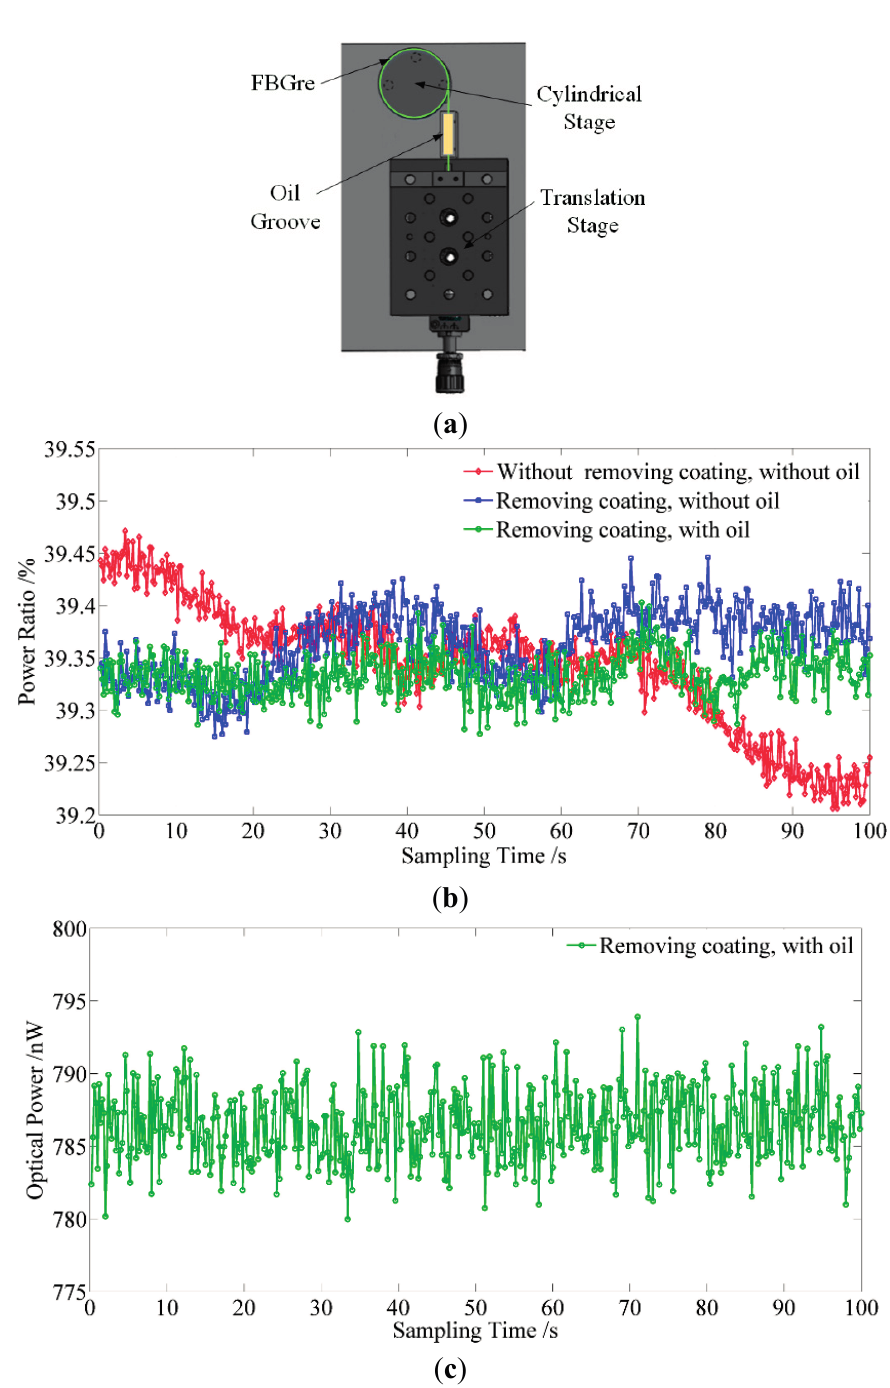
Figure 9. Experiment setup and result of the mechanical adjustment: ( a ) schematic diagram of the mechanical adjustment; ( b ) experimental results of the stability of the power ratio with reFBG stretched by the mechanical adjustment; ( c ) experimental results of the stability of the overlapping optical